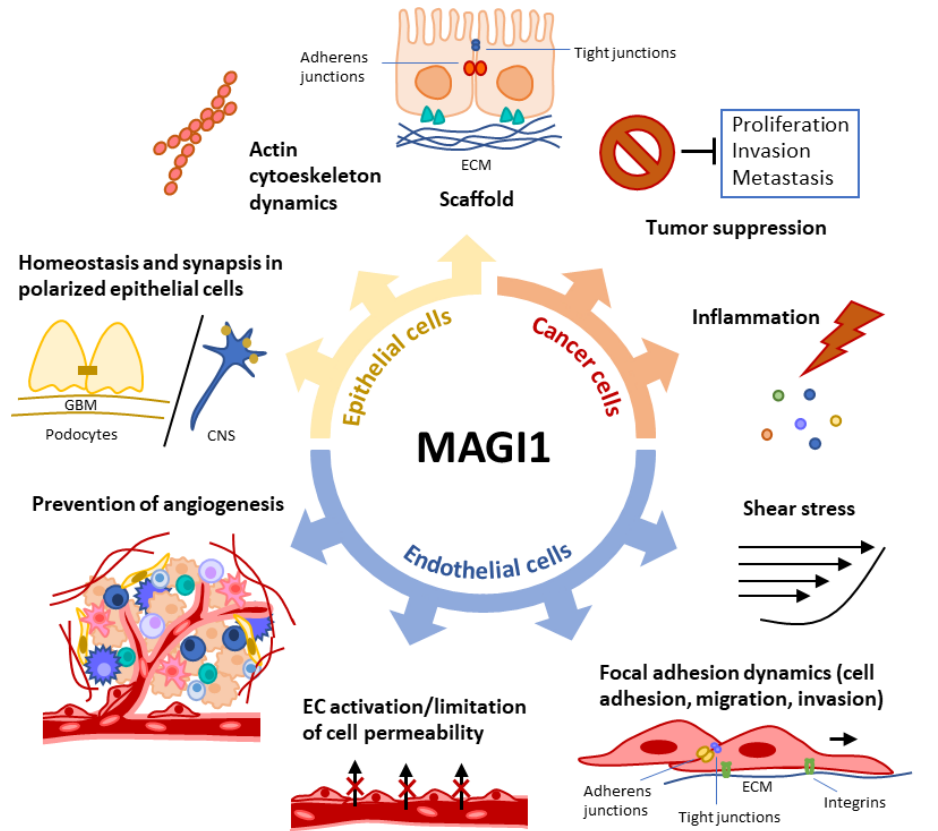
Figure 2. Summary of MAGI1 functions in epithelial, endothelial (EC), and cancer cells. In epithelial cells, MAGI1 is present in cell–cell contacts such as tight and adherens junctions and acts as a scaffold molecule. MAGI1 is also involved in regulating the actin cytoskeleton dynamics. In polarized epithelial cells, it is involved in receptor synaptic localization and homeostasis of ion channels. In ECs, MAGI1 is induced in response to fluid shear stress. MAGI1 also controls focal adhesion dynamics (stabilizing cell adhesion and decreasing migration and invasion). MAGI1 regulates EC activation and reduces cell permeability and angiogenesis. In cancer cells, MAGI1 acts as tumor suppressor preventing proliferation, invasion, and metastasis. There is increasing evidence of a link between MAGI1 and inflammation. ECM extracellular matrix; GBM glomerular basement membrane; CNS central nervous